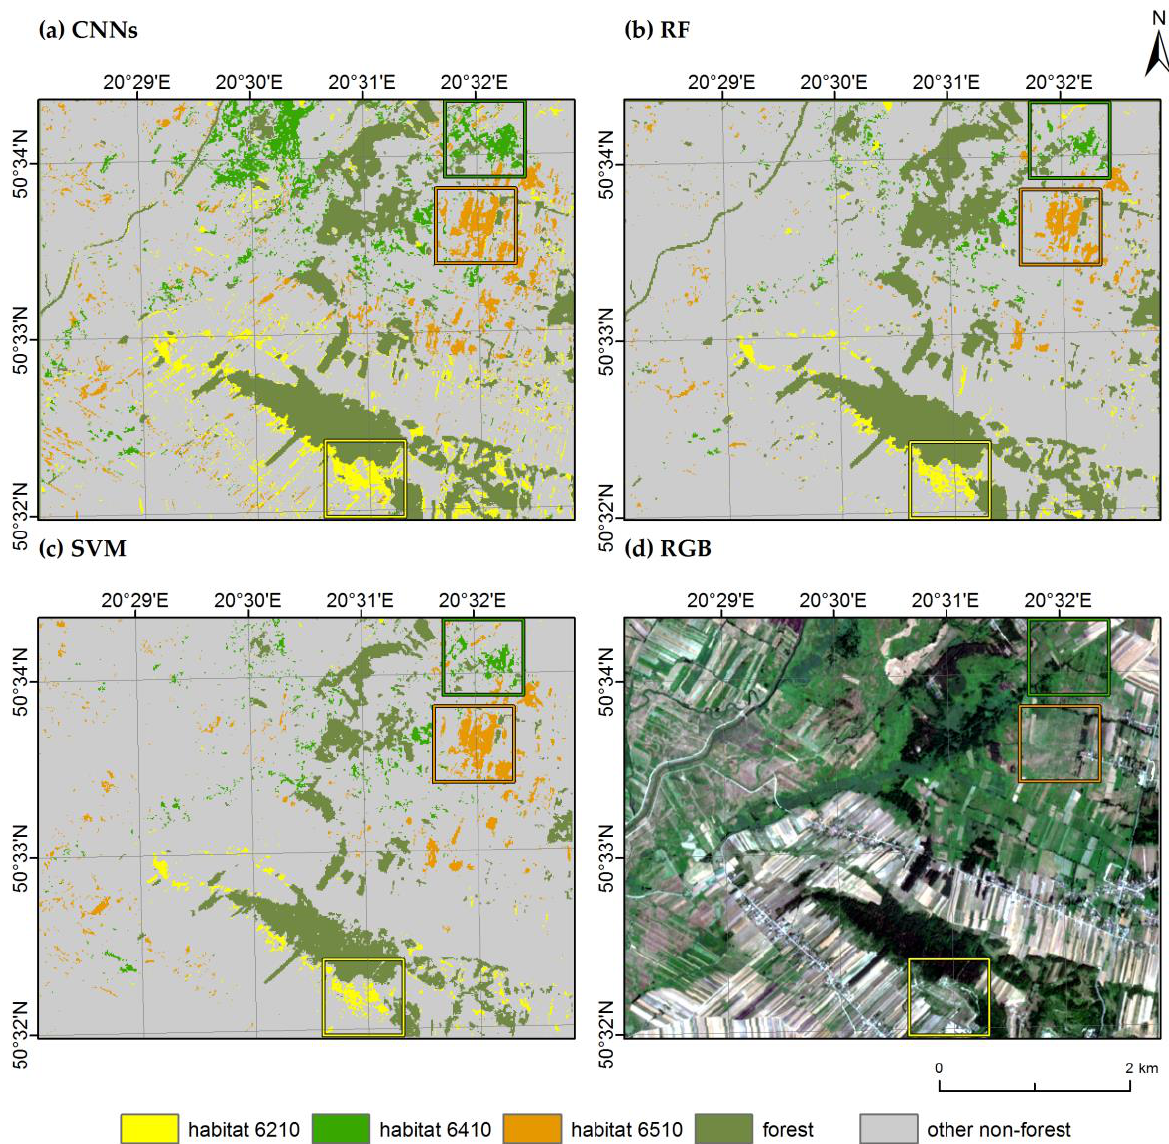
Figure 5. Maps of habitats and backgrounds produced with different algorithms: ( a ) CNNs, ( b ) RF, ( c ) SVM, and ( d ) Sentinel-2 data from 16 August 2017 (RGB 432 composition). Squares represent examples of the larger share of the area occupied by each habitat (colors correspond to Figure 6).